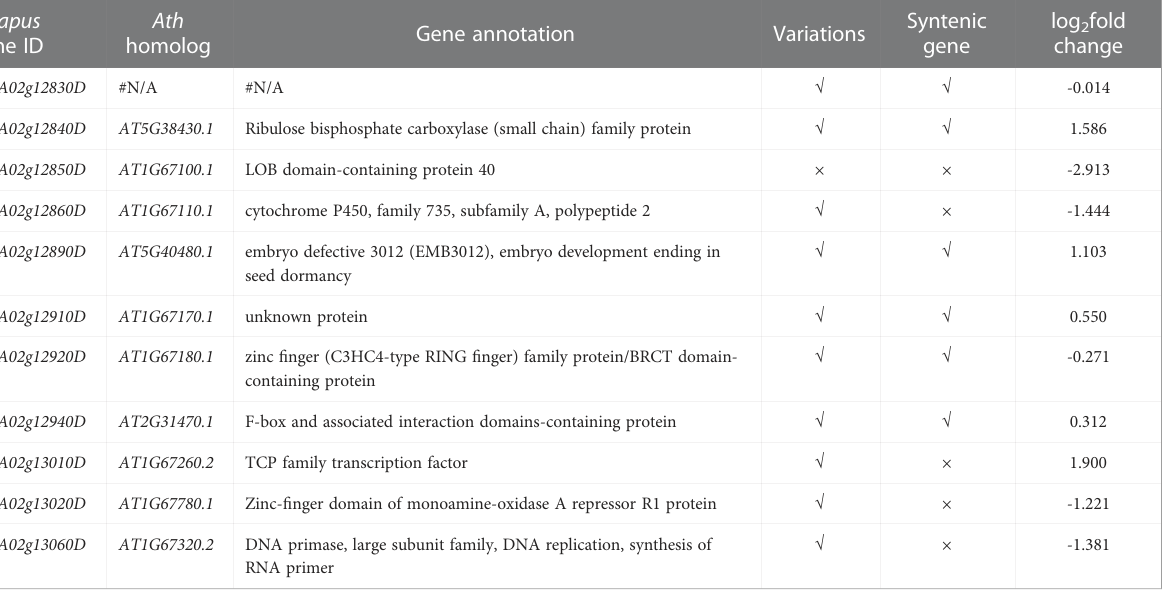
TABLE 3 Candidate genes for FBH in the qA02.FBH interval.